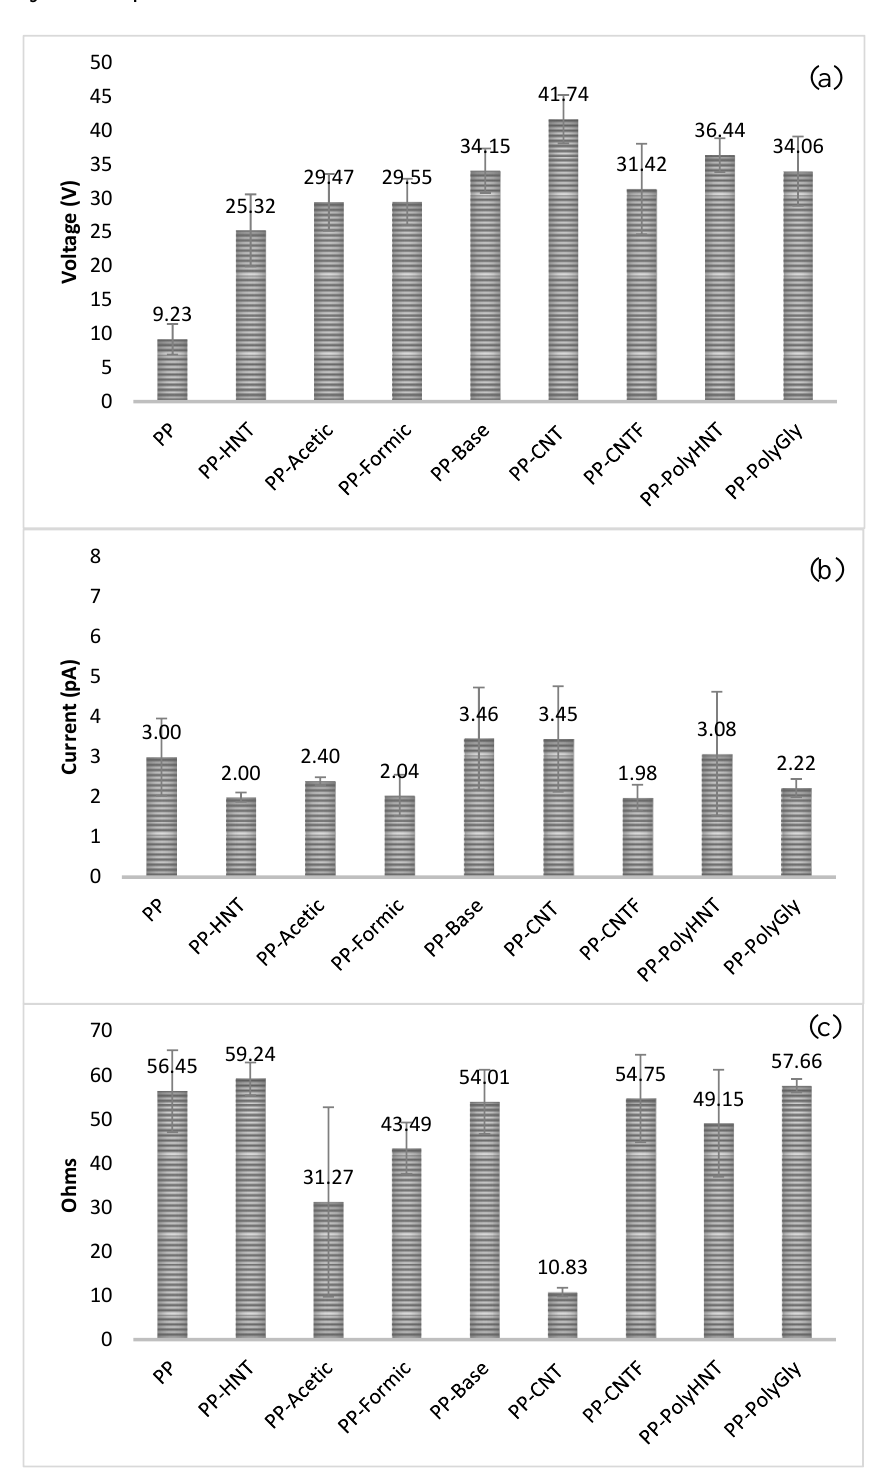
Figure 11. Voltage ( a ), Current ( b ) and electrical resistance ( c ) used to calculate the conductivity of